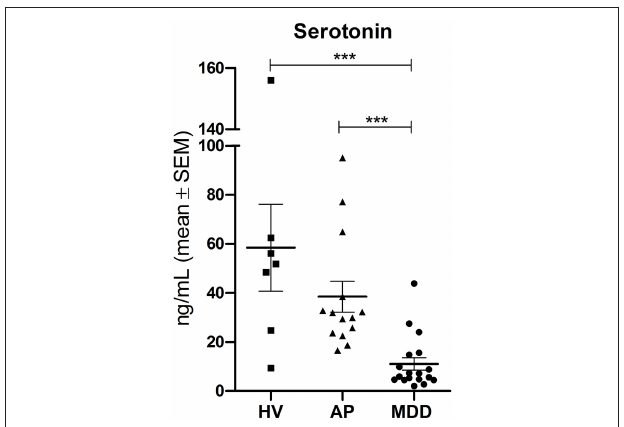
FIGURE 3 | Serum serotonin levels. Serotonin quantification by UPLC-ESI-HRMS in healthy volunteers (HV), airline pilots (AP), and depressed patients (MDD). Statistical analysis was performed by Kruskal-Wallis with Dunn’s multiple comparison test (*** p < 0.001). SEM, standard error of mean.